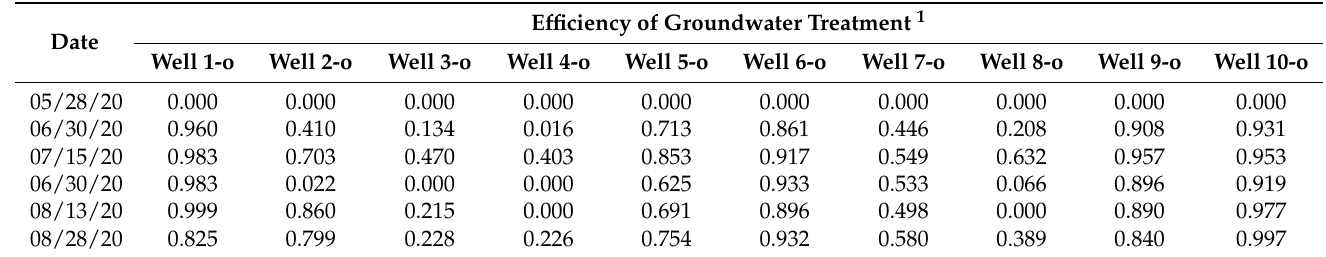
Table 3. Efficiency estimates of groundwater treatment in relation to initial TPH